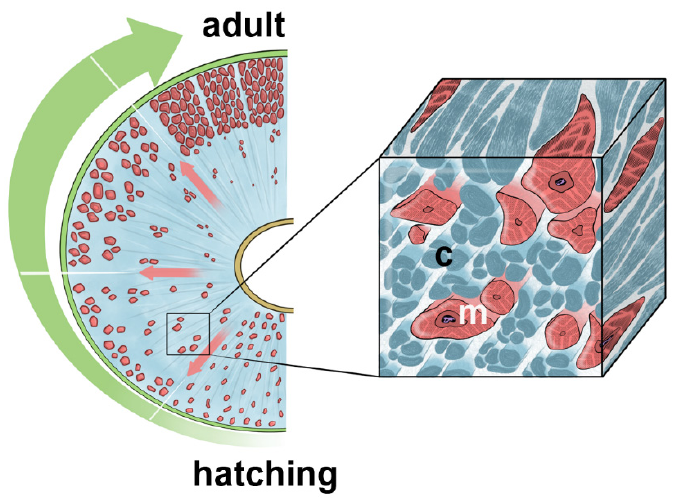
Figure 10. Schematic drawing highlighting modification of the body wall in H. verbana during development from hatching to adult. Collagenic scaffold (c) in pale blue and myocytes (m) in